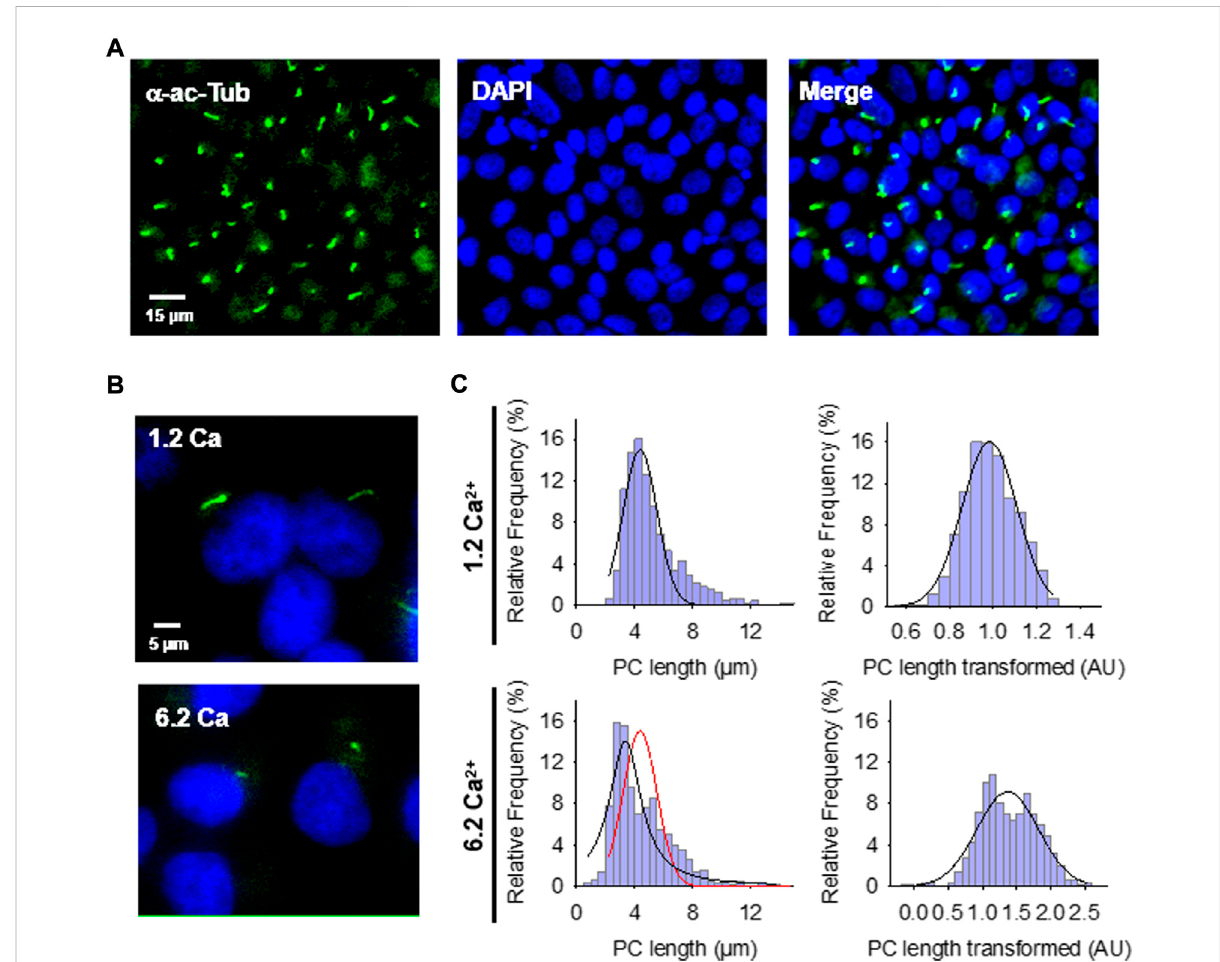
FIGURE 1 Effect of extracellular Ca 2+ on the primary cilium (PC) length of wild-type LLC-PK1 cells. (A) Con fl uent monolayers of wild-type LLC-PK1 cells were labeled with an anti-acetylated α -tubulin antibody (Green, Left Panel), and DAPI(Blue, Middle Panel). The merged image is shown on the Right. (B) Acetylated- α -tubulin immunolabeling of con fl uent of LLC-PK1 cell monolayers was used to observe the primary cilium at normal (1.2 Ca, Top panel) and high (6.2 Ca) external Ca 2+ concentrations. Merged images also show cell nuclei by DAPI labeling (Blue). (C) Histograms of ciliary length measurements in standard (1.2 mM, Top) and high (6.2 mM, Bottom) Ca 2+ concentration are shown before (Left) and after (Right), Box-Cox transformation. A not Normal left-skewed distribution of data is observed before the transformation. Please note that Box-Cox